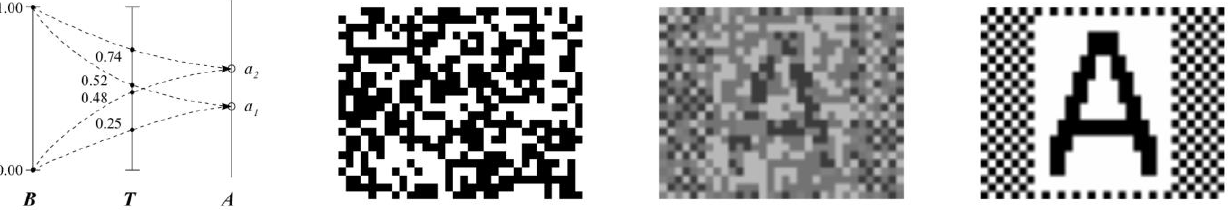
Figure 10. Bias-ambiguous, trigger-scrambling. Left: diagram of rule set f 6 , with arrows linking the intensities that are used. Middle, left: the random bias image from an image sequence generated by rule set f 6 . Middle, right: the scrambled trigger image. Right: the target afterimage pattern, with a 1 , a 2 shown as before.